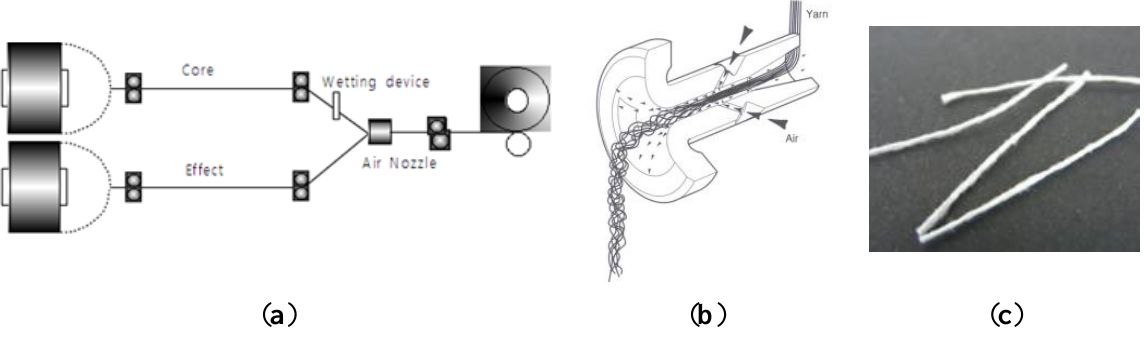
Figure 3. Production process of bundled PA fiber using air textured yarn. ( a ) Air texturing